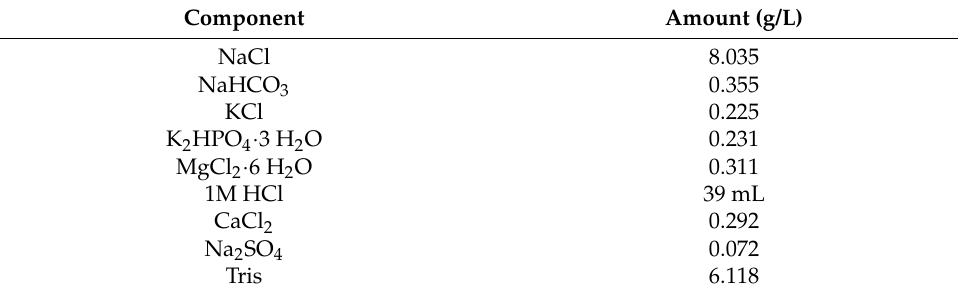
Table 4. Composition of the